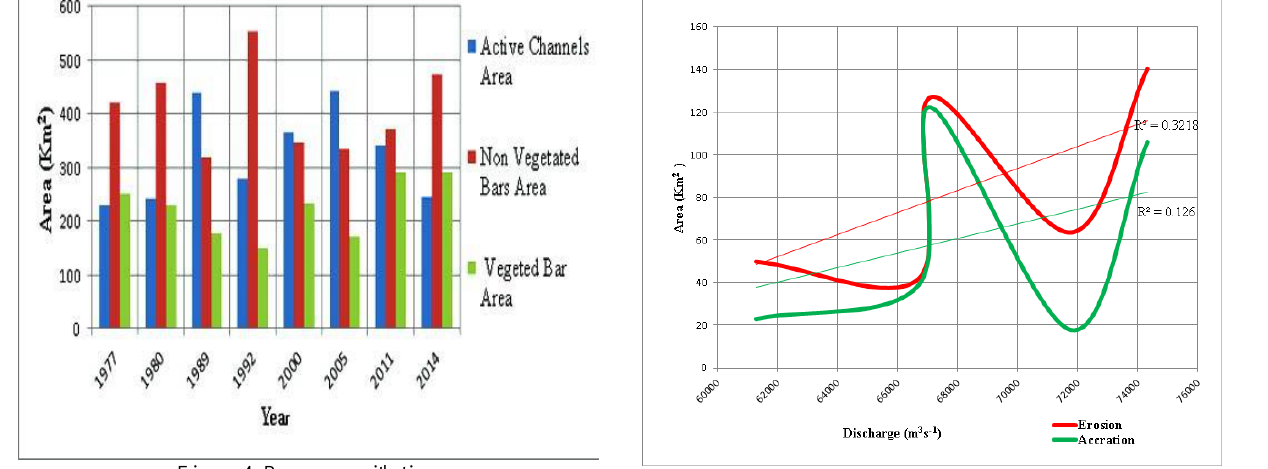
Figure 6. Erosion and Accretion with